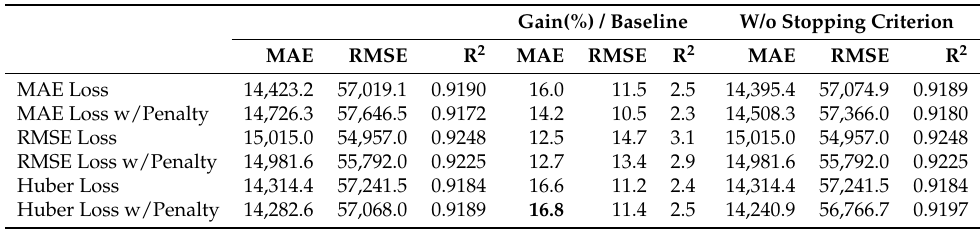
Table 7. Results obtained with the application of the encoder–decoder model leveraging different losses for the overall amount of national withdrawals.